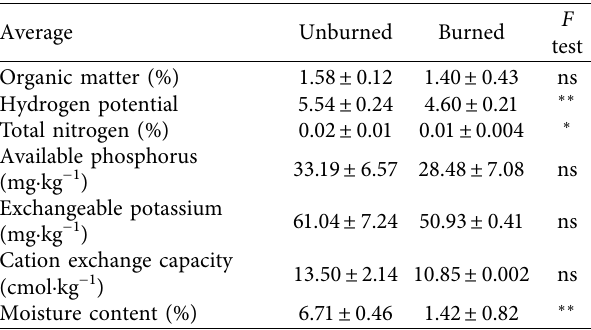
Table 1: Soil physiochemical properties after unburned and burned sugarcane harvesting at soil depth